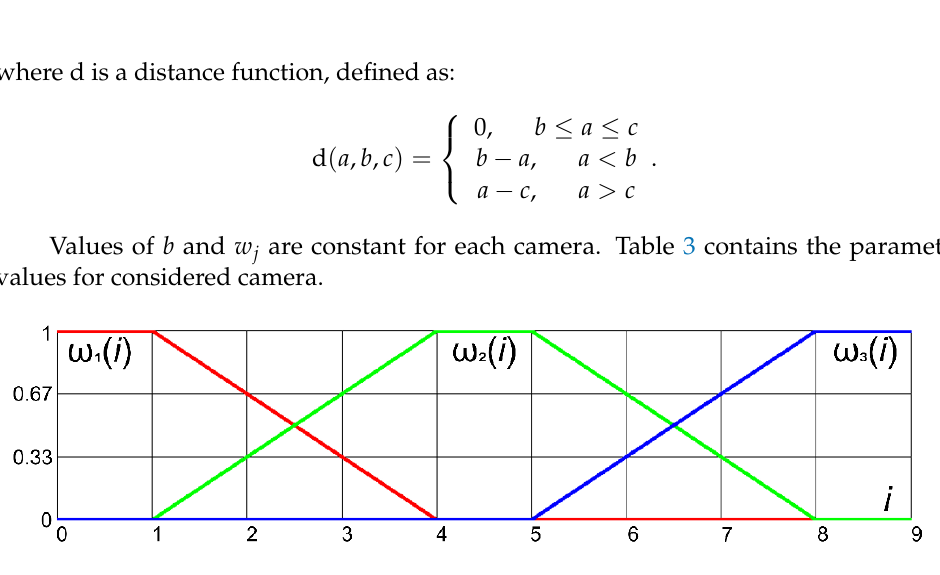
Figure 9. The graphs of used base functions, which determines the influence of the parameters w j on high, mid and low frequencies. Table 3. Constant parameters for frequency characteristics computation, calculated for camera, observing Klyuchevskoy volcano.